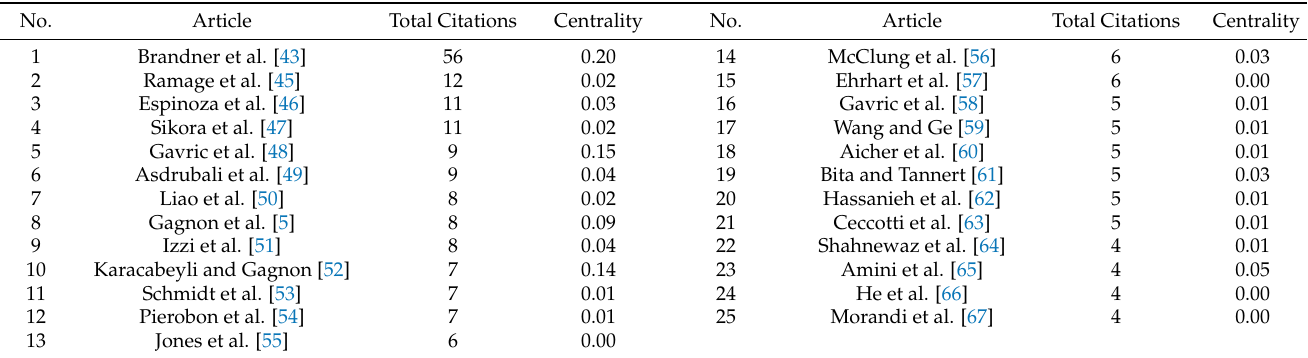
Table 6. Co-citation clusters of cross-laminated timber in construction from 2006 to 2022.